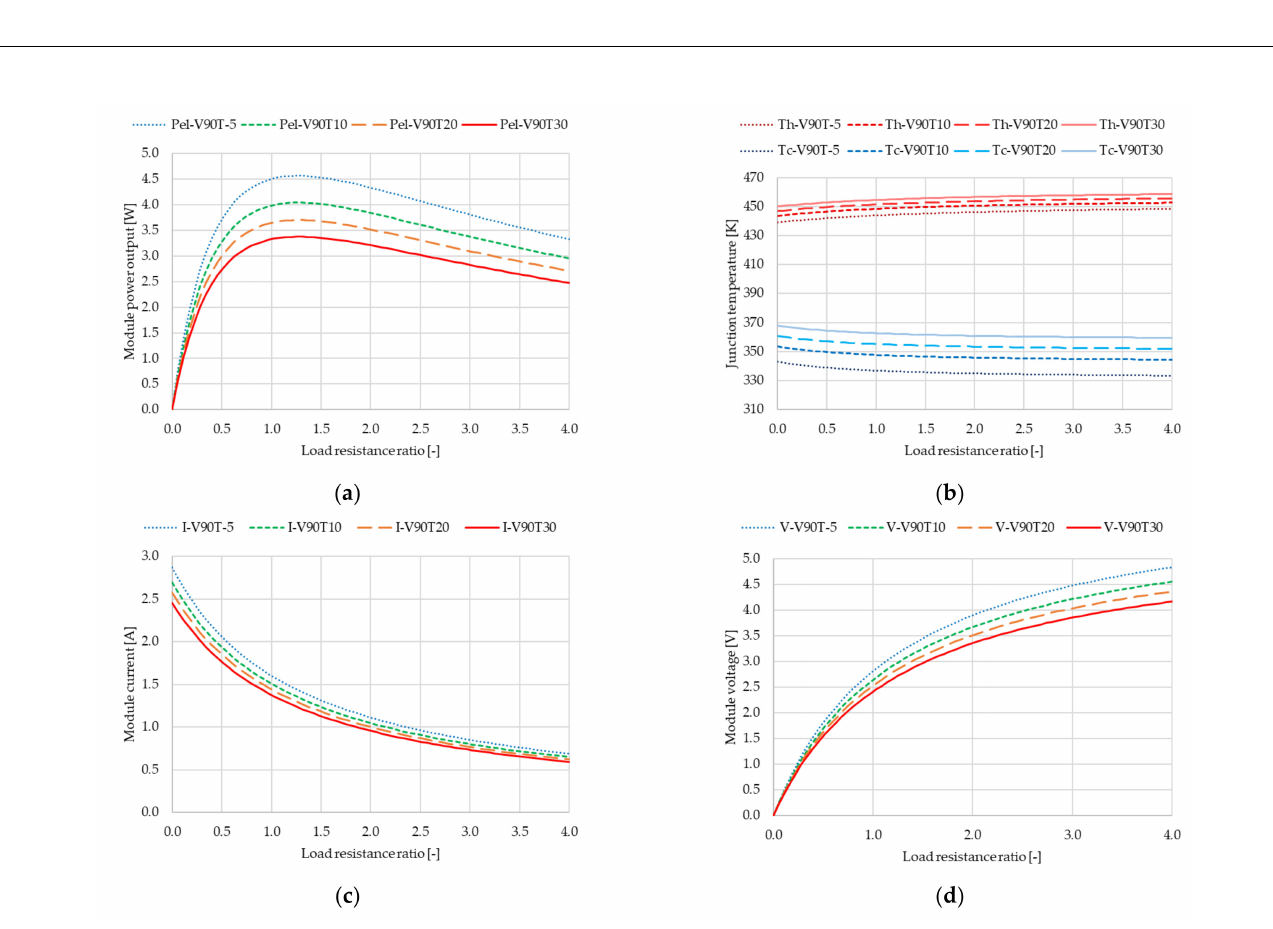
Figure 16. ( a ) Module power output, ( b ) junction temperature, ( c ) module current, and ( d ) module voltage with respect to the load resistance ratio for a velocity of 90 km/h at various temperatures ( − 5, 10, 20, and 30 ◦